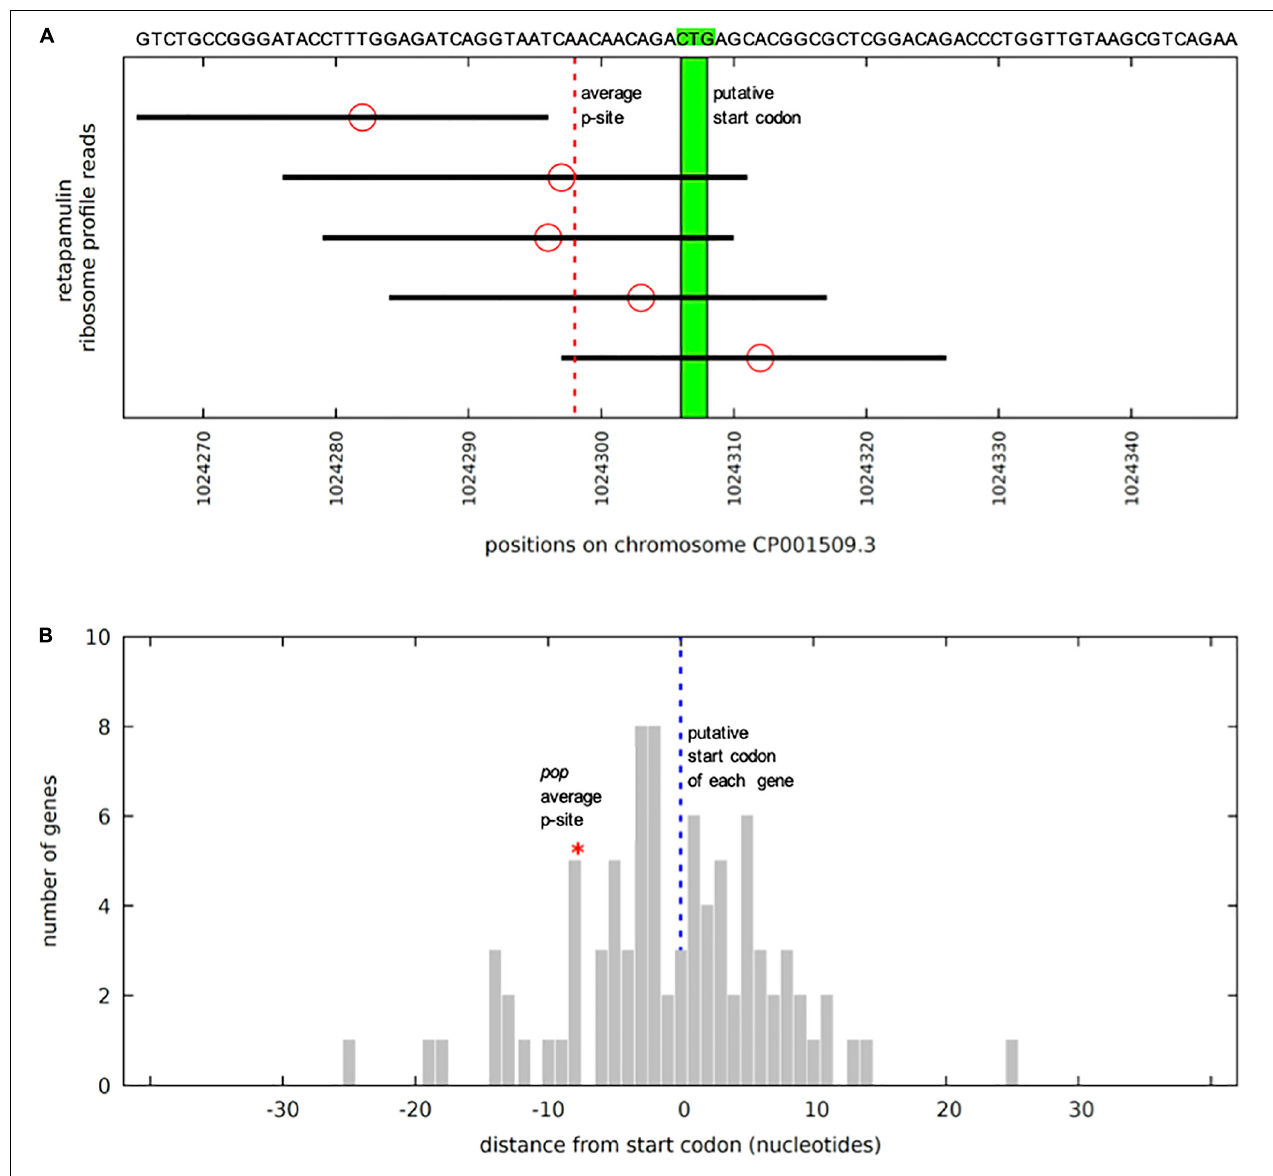
FIGURE 3 | pop in stalled-ribosome profiling data of E. coli BL21. (A) Reads (black bars) antisense to ompA in the region of pop (sequence indicated above). The five reads situated on the forward strand antisense to ompA are shown, aligned to the BL21 chromosome CP001509.3. Ribosomal p -site locations (red circles) are predicted based on the method of Meydan et al. (2019) – counting 15 nucleotides from the 3 (cid:48) end of the read. As there is no clear peak, instead the mean of all of the p -sites was calculated. The mean is shown with a dotted red line, pictured in relation to the putative start codon CTG in green. Significance of 5 reads was calculated based on the read distribution modeled as a binomial process. The total sequence space available is 3943267 nucleotides. If we conservatively assume a target size of 100 bp, this equates to a probability of success for a single trial of 100/3943267 = 0.0000254. We find 56812 reads antisense to annotated genes, which is the number of independent trials, if we generously assume as the null hypothesis that all are due to non-functional “background” translation events. With these parameters, the probability of obtaining five or more reads in our target region, i.e., P ( x ≥ 5), is equal to 0.0159, therefore 5 reads are significant ( p -value ≤ 0.05). (B) Average ribosomal p -site positions for 85 weakly expressed genes. Positions of average p -sites relative to annotated start codons (blue dotted line), as illustrated in panel (A) , are plotted for all 85 weakly expressed forward (+) strand annotated gene start regions. Weakly expressed is here defined as having at least four mapped reads within 30 nucleotides of the annotated start site, but no single position (peak) with three or more reads. The location of the average p -site for pop (red asterisk) lies within this distribution, indicating that the observed cluster of ribosome-stalled reads near the CTG site is informative. Thus, we assume that CTG might be the start codon for pop